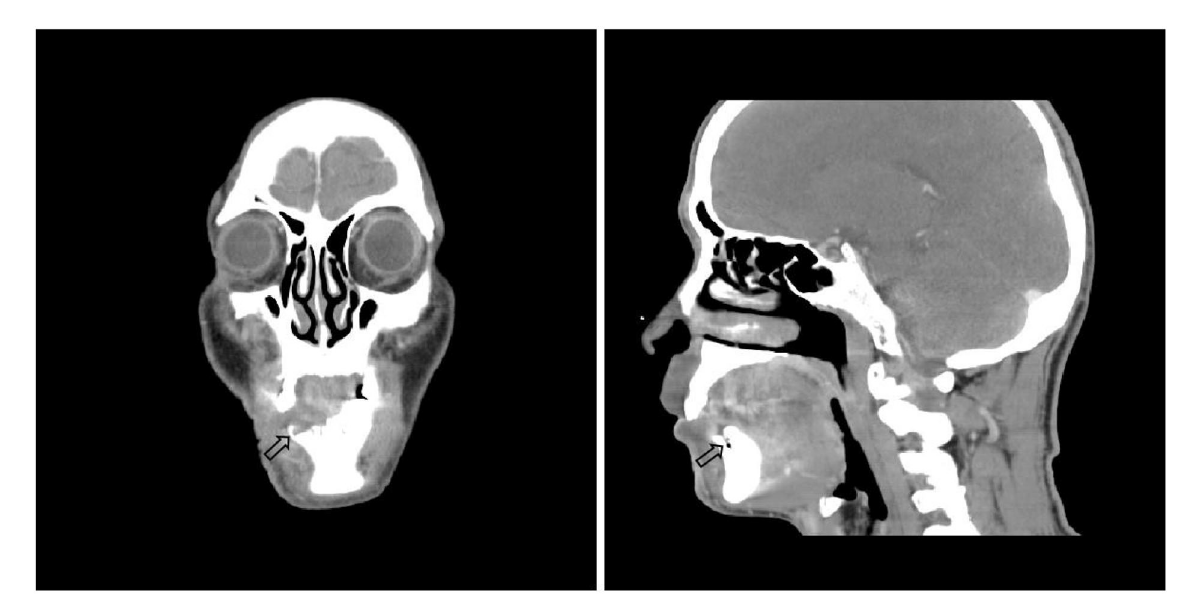
FIGURE3 Cranial neck enhanced CT(2021-4-30) showed the right side of the lower alveolar bone is partially absorbed, and there is no corresponding tooth. No tumor or other suspicious